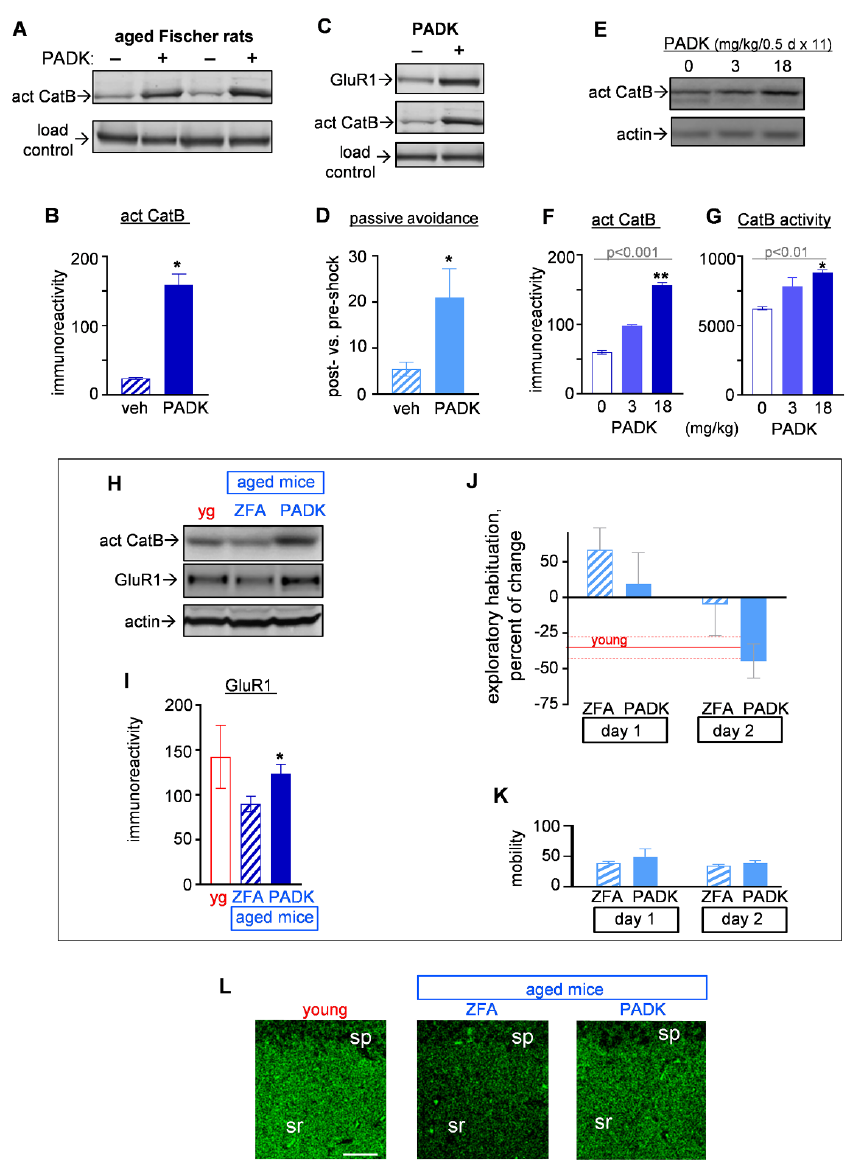
Figure 6. Synaptic and cognitive e ff ects produced by the positive CatB modulator PADK in models of mild cognitive impairment (MCI). Equal protein aliquots of hippocampal homogenates from vehicle- and PADK-treated female Fischer rats are shown in cropped immunoblots that were assessed for active CatB ( A ; see Supplementary Materials) which was quantified by integrated optical density measures ( B ; Mann – Whitney test: * p < 0.05). Fischer rat samples in cropped immunoblots were also stained for GluR1 in parallel with CatB ( C ; see Supplementary Materials). The groups of Fischer rats were tested for passive avoidance, and those treated with PADK exhibited a more pronounced level of learning indicated from the ratio of post-shock/pre-shock latency times ( D ; Mann – Whitney test: * p < 0.05). For oral dosing, Sprague-Dawley rats received 20 mg/kg inactive ZFA (designated as 0 PADK) or 3 – 18 mg/kg PADK twice daily for 11 days, and brain samples were subsequently assessed as shown in cropped immunoblots for active CatB ( E ; also see Supplementary Materials). Integrated optical densities of the active CatB isoform exhibit a dose-dependent increase ( F ) (Kruskal–Wallis test: p < 0.001; post